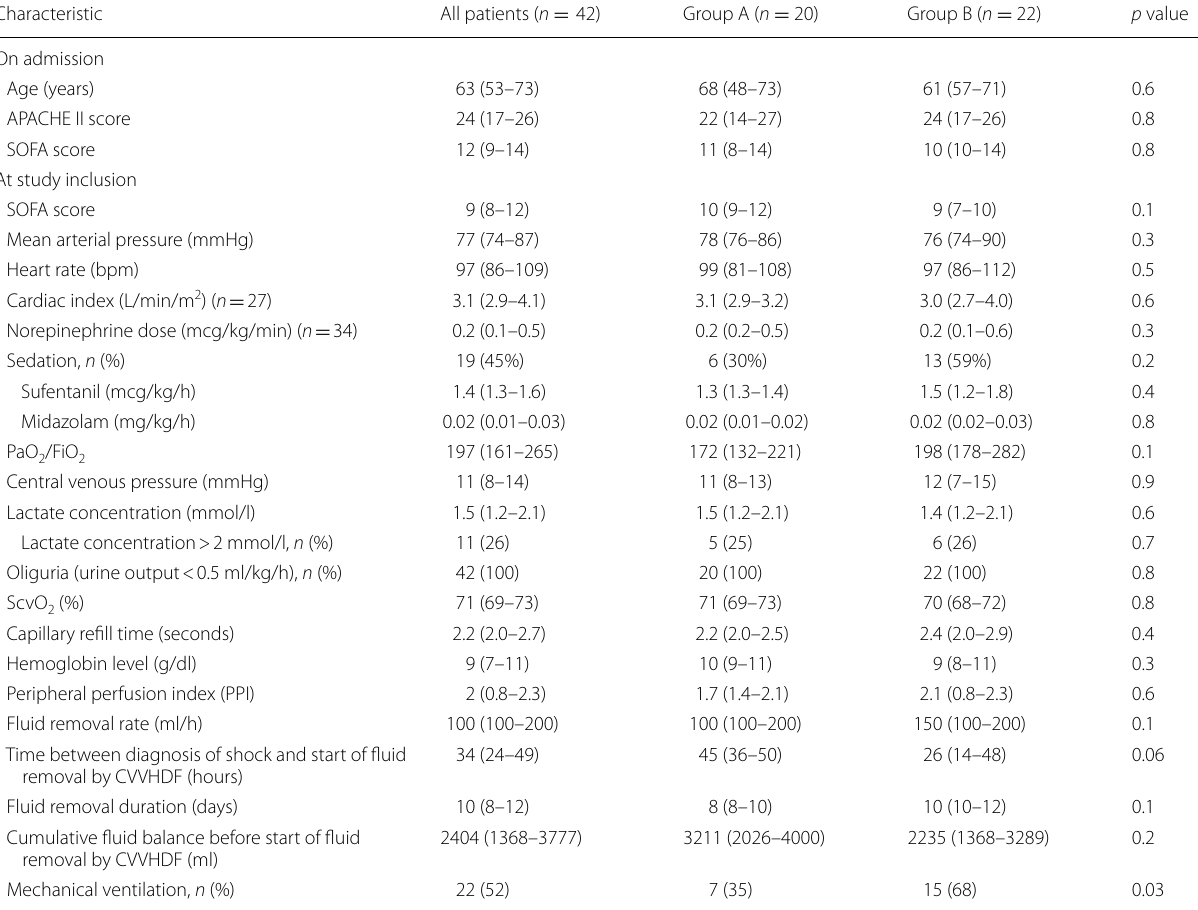
Table 1 Main clinical characteristics at admission or study